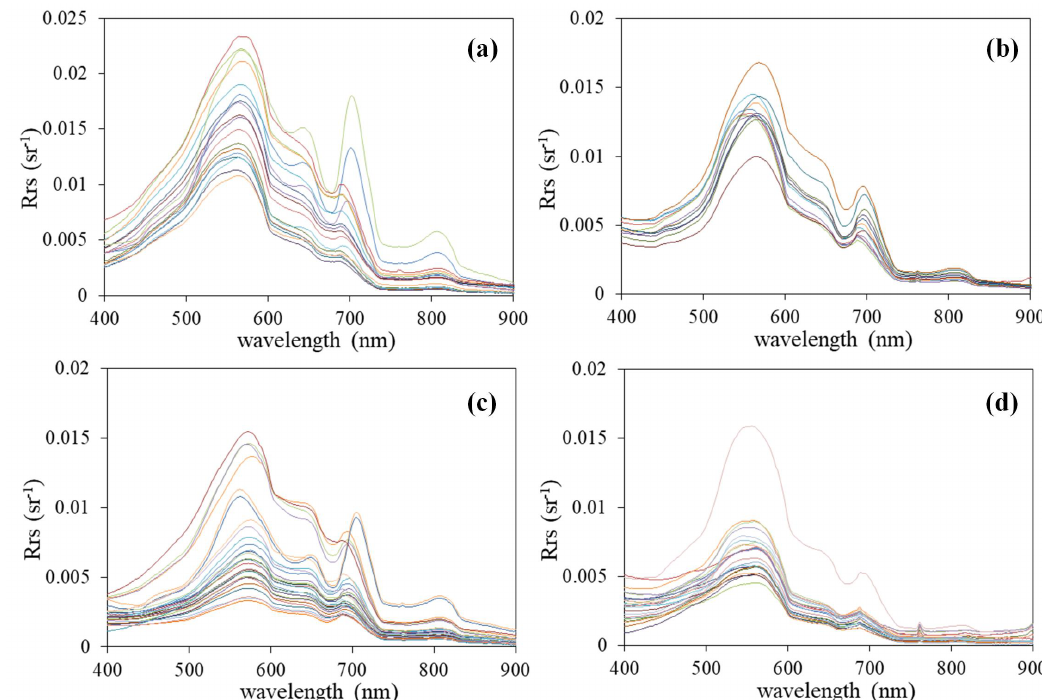
Figure 2. Field measured remote sensing reflectance at the sampling sites in the study regions: ( a ) Guanting Reservoir, ( b ) Daheiting Reservoir, ( c ) Lake Baiyangdian and ( d ) Panjiakou